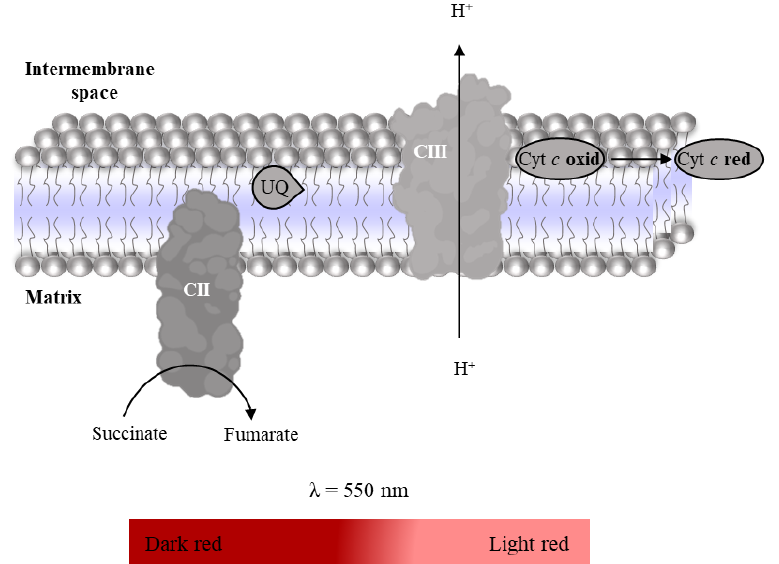
Figure 11. Reduction of oxidized Cyt c with succinate oxidation to fumarate. Table 9. Conditions and flow setup for Complex II – III conjugated activity assay.